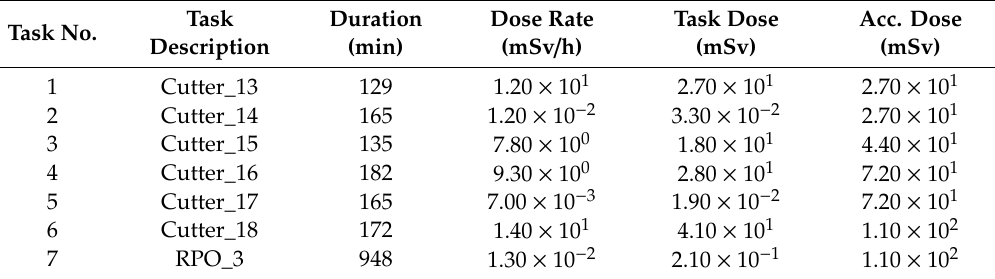
Table 8. Task information for the fragmentation of the lower part.